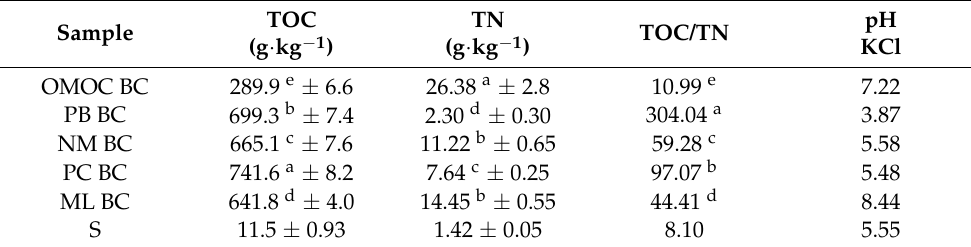
Table 1. Content of total organic carbon (TOC), total nitrogen (TN) and TOC/TN ratio in biochars and